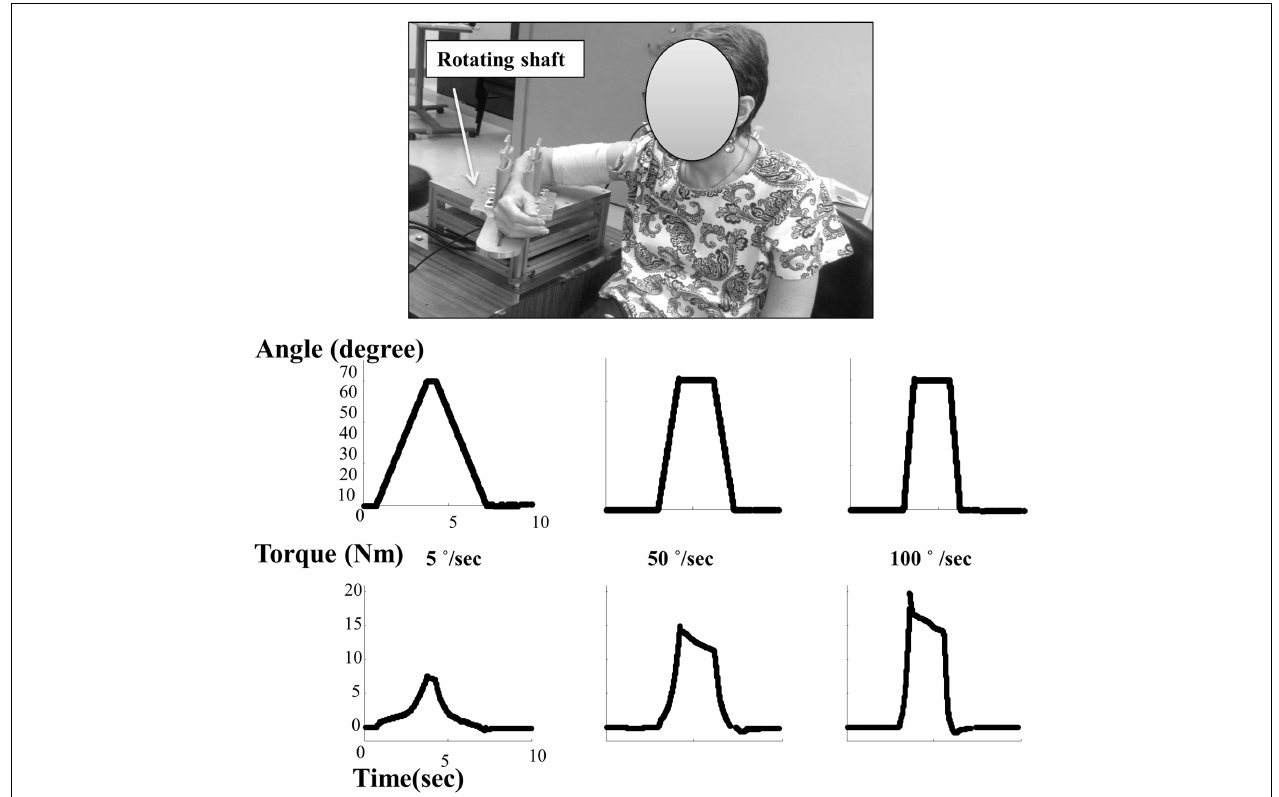
FIGURE 1 | Experimental setting and representative torque–angle profiles at different speeds